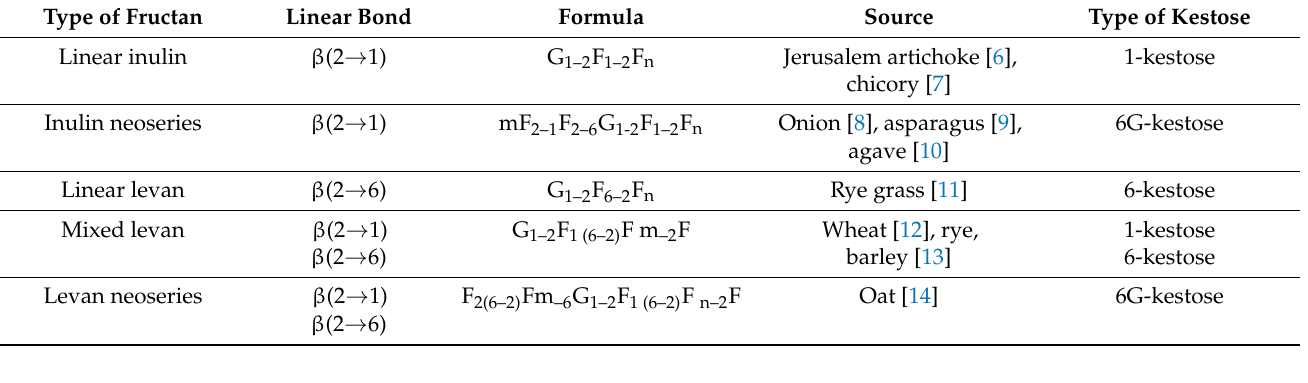
Table 1. Five types of fructans in higher plants.